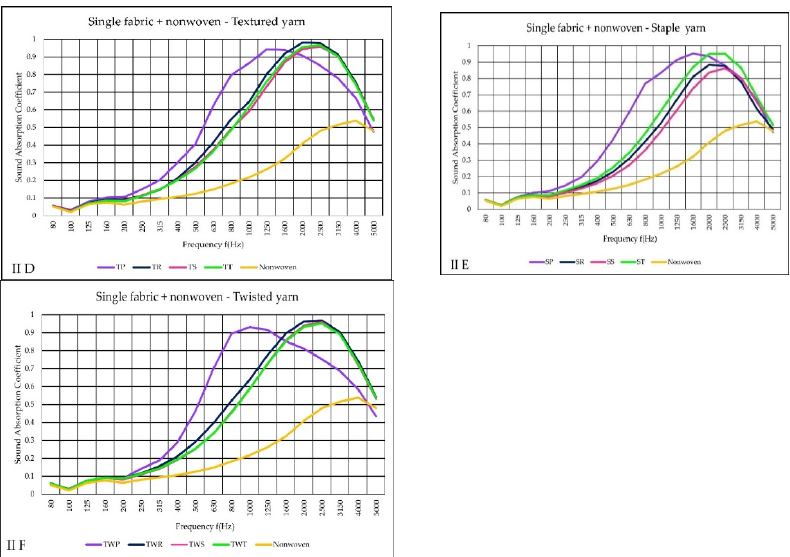
Figure 5. Sound absorption coefficient ( α ) versus frequency f (Hz) result of measurement variant (I) ( A – C ) single woven fabric.